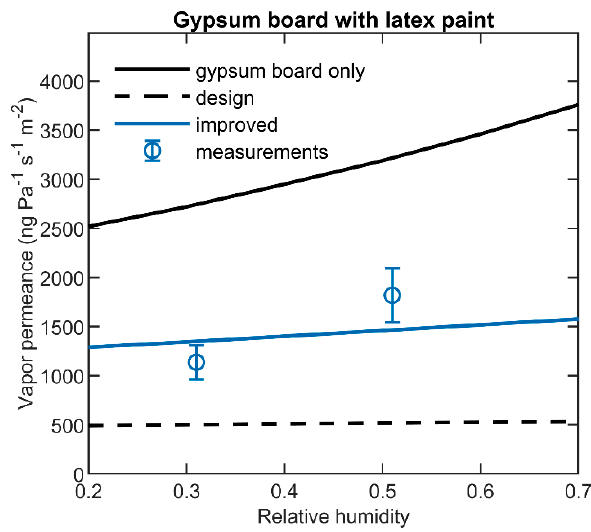
Figure 7. Water vapor permeance of gypsum board with no paint, paint (on gypsum) with design value sd = 0.32 m, and the improved model of paint on gypsum with sd = 0.073 m. Also shown are measurements of permeance for paint on gypsum board which informed the improved model.